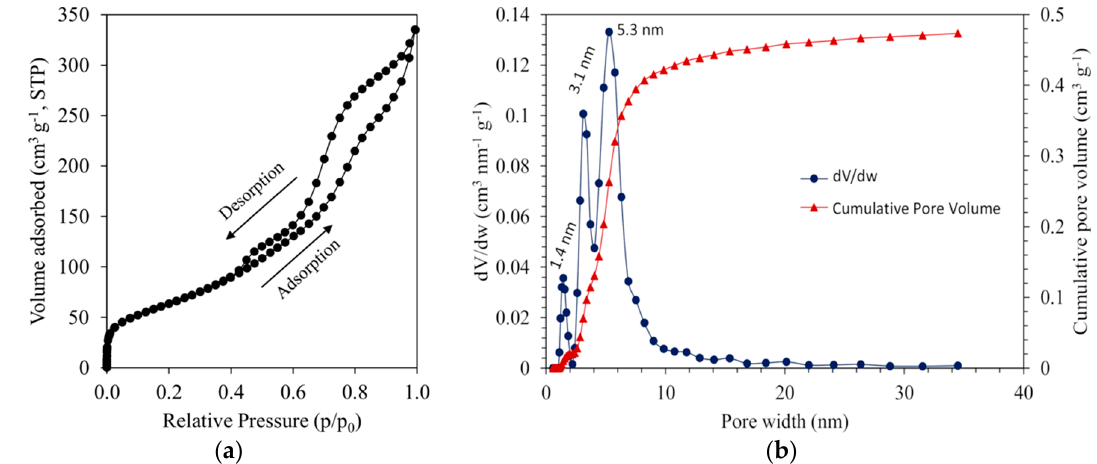
Figure 6. ( a ) N 2 adsorption-desorption isotherms and ( b ) differential (blue curve) and cumulative (red curve) pore size distribution of gamma aluminium oxide.